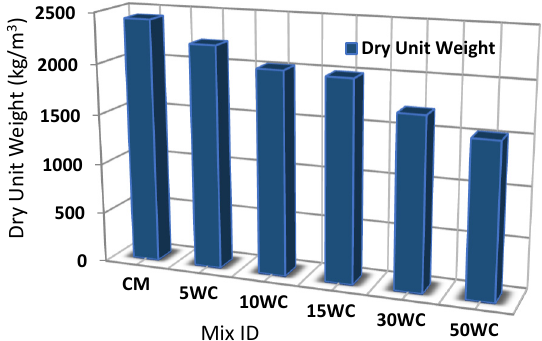
Figure 6. Values of dry unit weight.